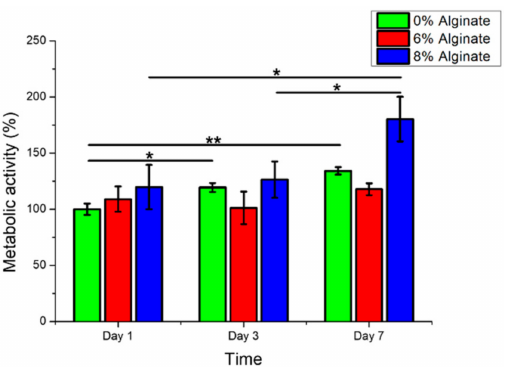
Figure 4. Metabolic activity assay from C2C12 cells in GelMA hydrogel with alginate concentrations 6% and 8% (w / v) crosslinked with UV and CaCl 2 over time (* p < 0.05 and ** p < 0.01). C2C12 myoblasts cultured in GelMA and GelMA-alginate hydrogels started to spread after 3 days